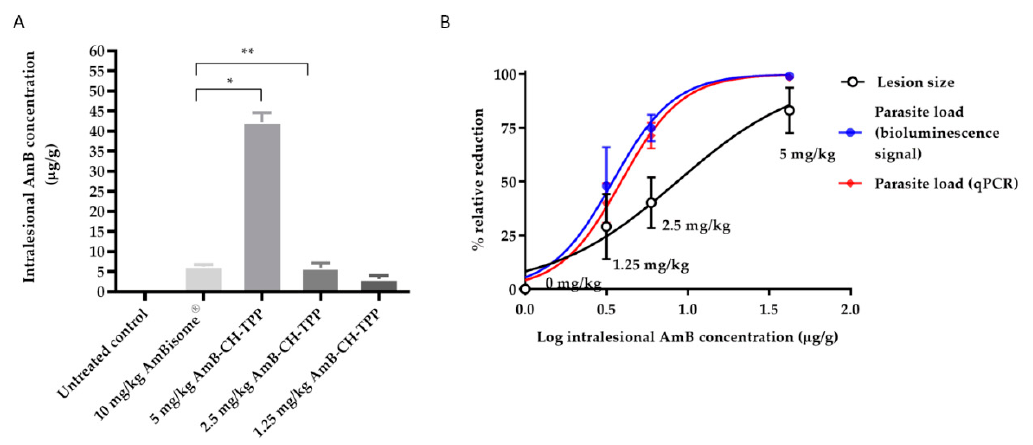
Figure 5. Multiple dose skin pharmacokinetics of AmB-CH-TPP nanoparticles and AmBisome ® . L. major -infected BALB/c mice received intravenous doses of AmBisome ® (G3, 10 mg/kg/QAD for 10 days; i.v.), AmB-CH-TPP nanoparticles (G4, 5 mg of AmB/kg/QAD for 10 days; i.v.), AmB-CH-TPP nanoparticles (G5, 2.5 mg of AmB/kg/QAD for 10 days; i.v.) and AmB-CH-TPP nanoparticles (G6, 1.25 mg of AmB/kg/QAD for 10 days; i.v.). Then, 24 h after the last dosing, AmB levels in skin were determined. The CL lesion was localized on the rump, while the back skin of same mice used as lesion-